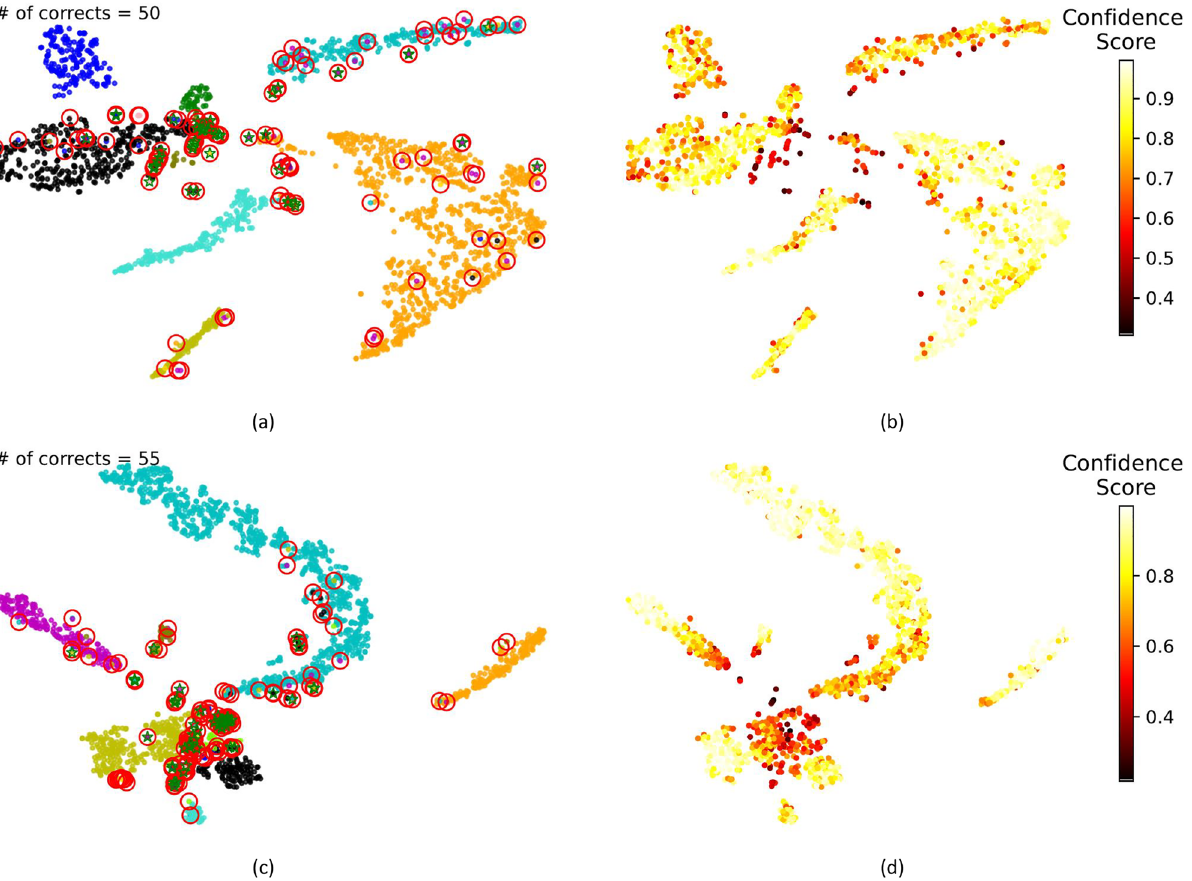
Figure 1. t-SNE embeddings of the Segerstolpe (top) and Baron Mouse (bottom) datasets ( a ) and ( c ) Erroneous samples are marked with red circles, correctly detected erroneous samples are marked with green stars ( b ) and ( d ) Heat maps show the confidence scores of each sample in the